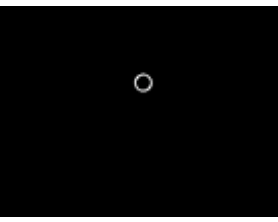
Figure 3. Round traffic sign extracted based on the labeling process.